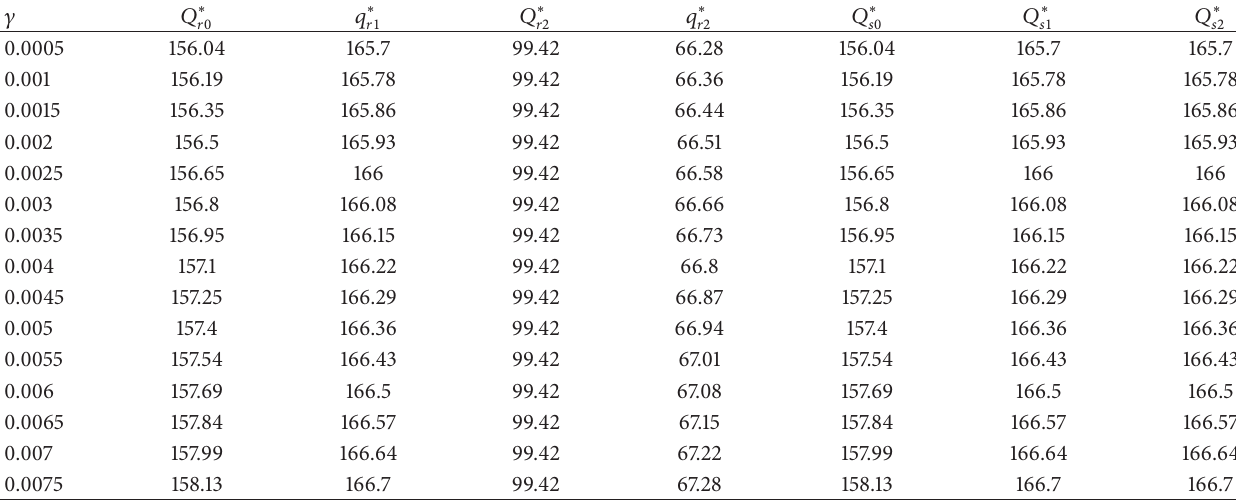
Table 3: The impact of 𝛾 on the optimal